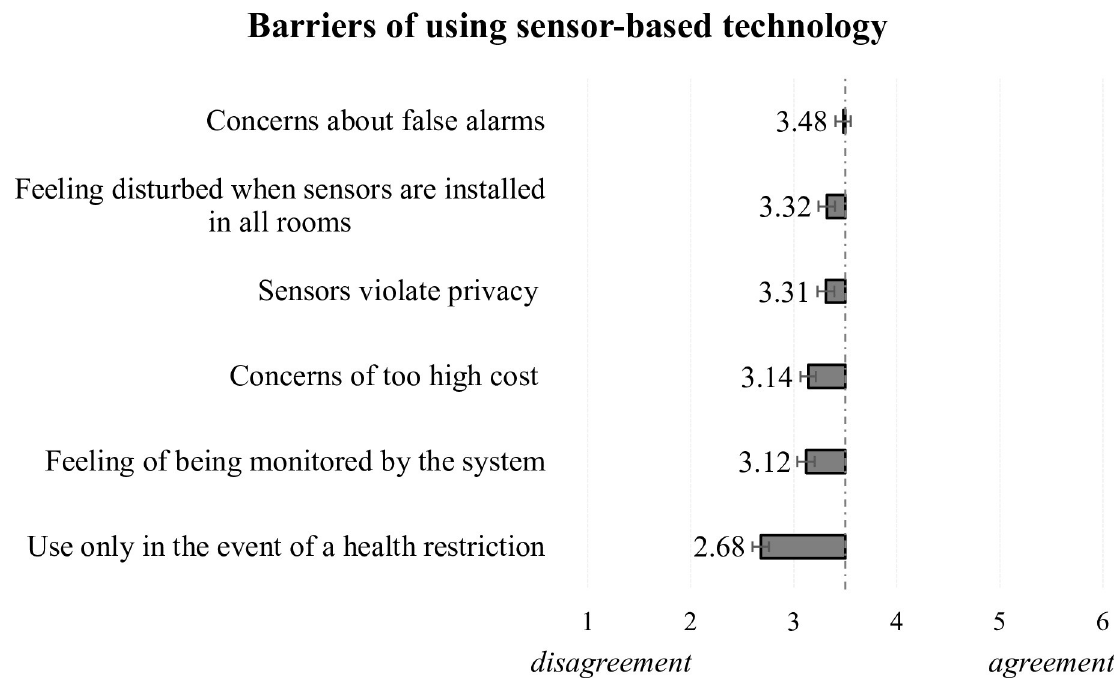
Fig 5. Perceptions of barriers when using sensor-based